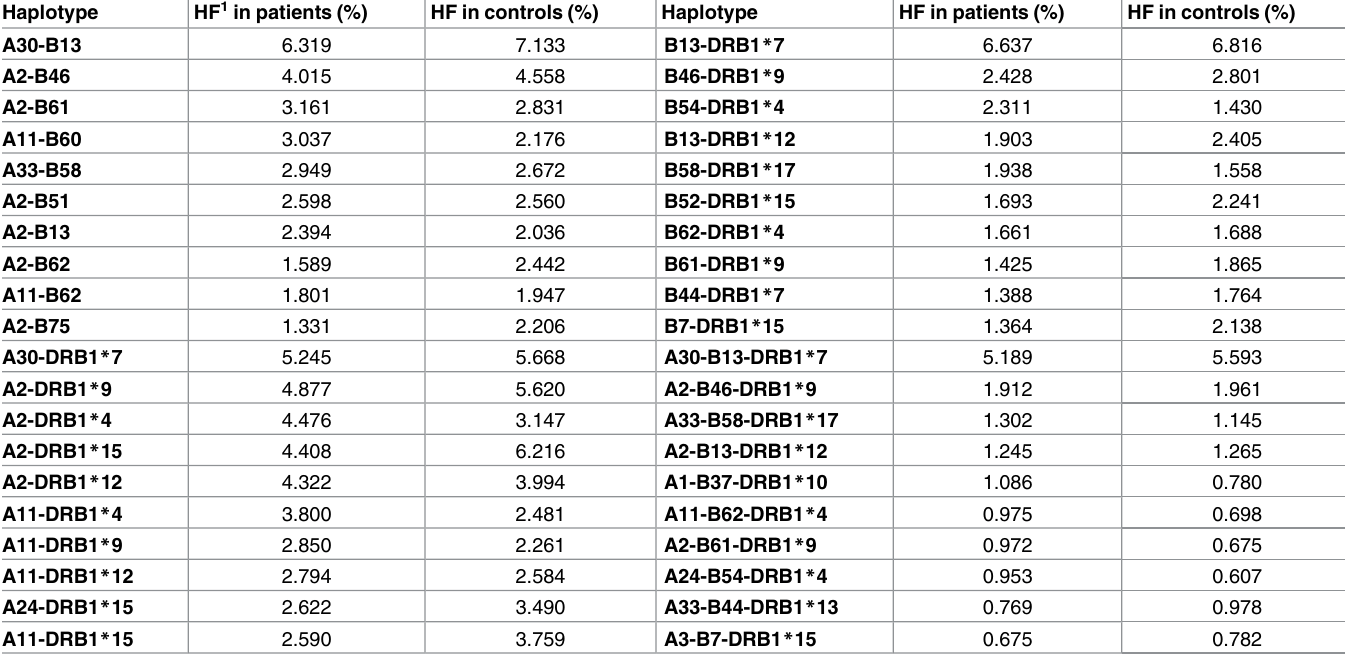
Table 2. The 10 most frequent haplotypes of HLA-A-B, HLA-A-DRB1, HLA-B-DRB1 and HLA-A-B-DRB1.